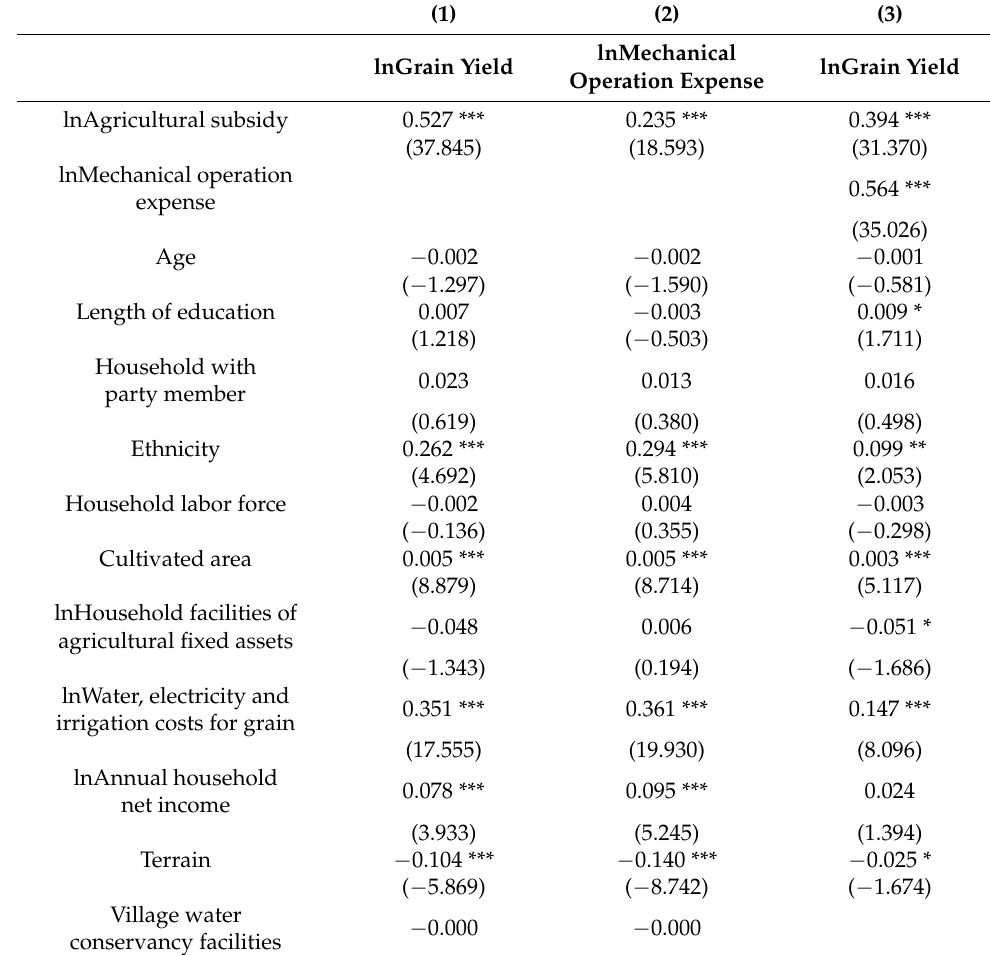
Table 3. Mediating effects of